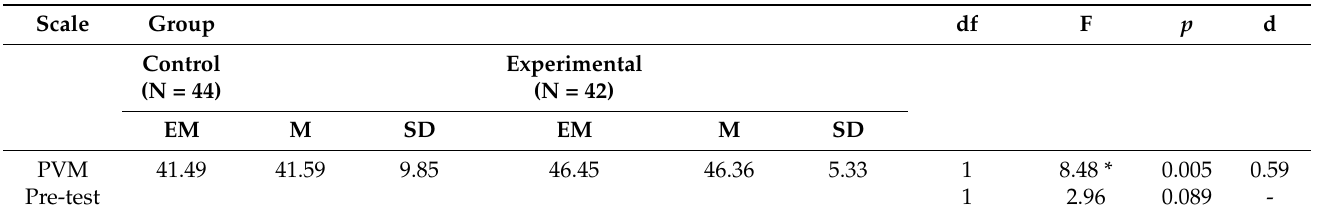
Table 2. ANCOVA results for post-PVM